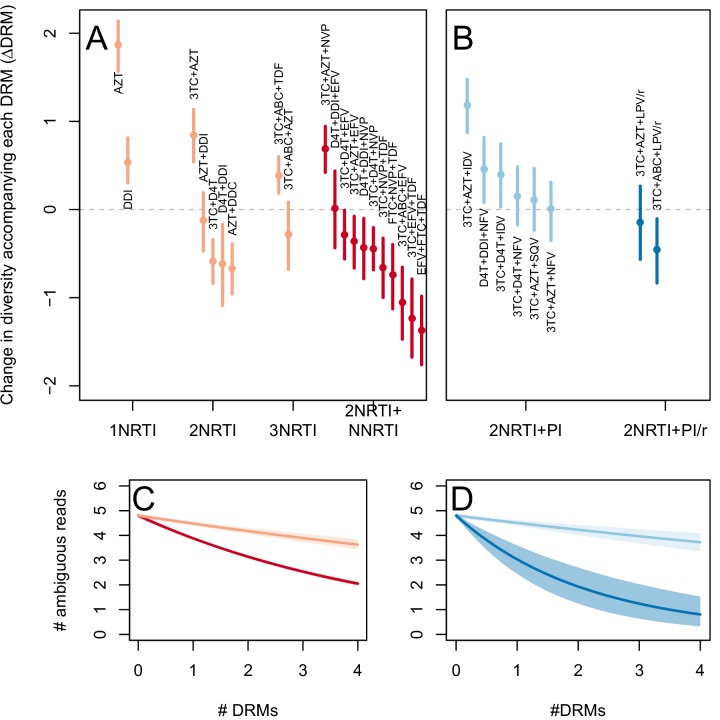
Drug resistance mutations are correlated with diversity reduction differently in different types of treatments with un-truncated data.This figure is analogous with Figure 3 from the main text, but in this case, the data are not truncated to only include the patients with 4 or fewer DRMs. The figure caption is otherwise shared with Figure 3.